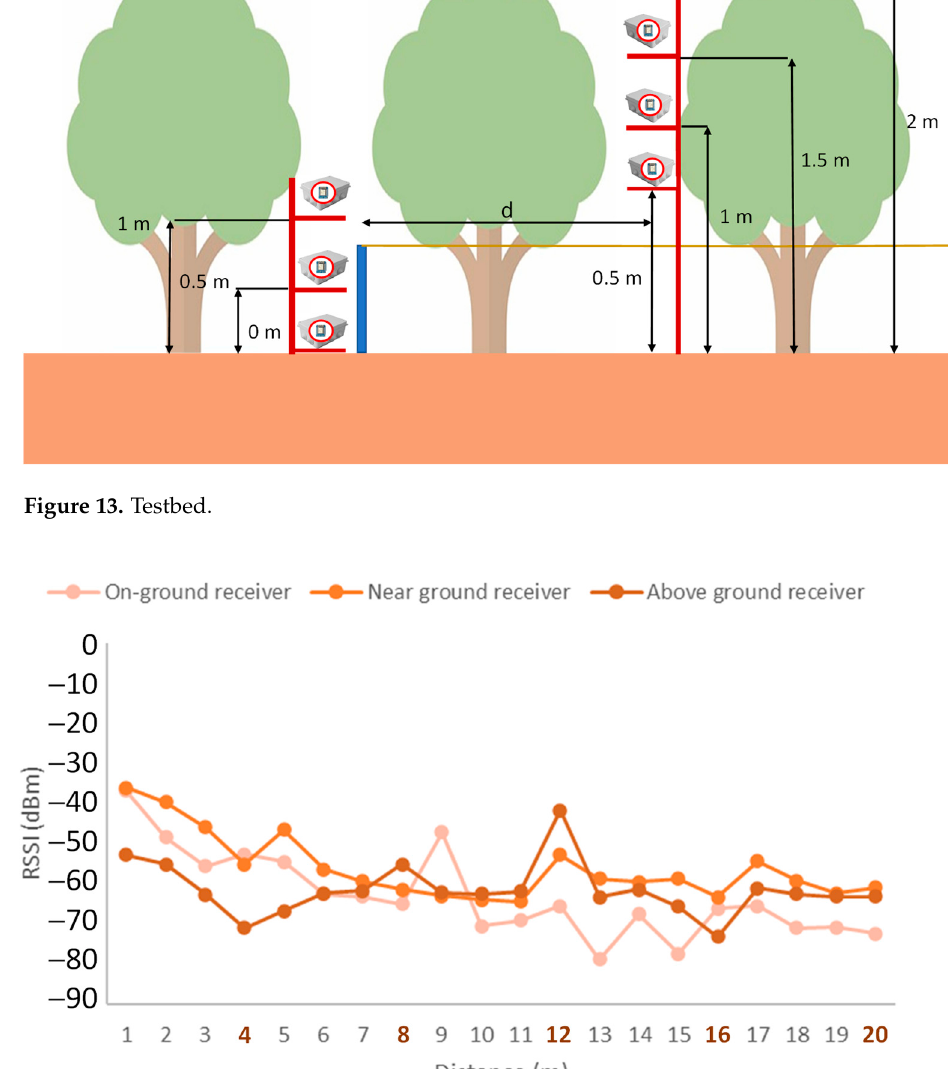
Figure 14. Emitter at height of 0.5 m.